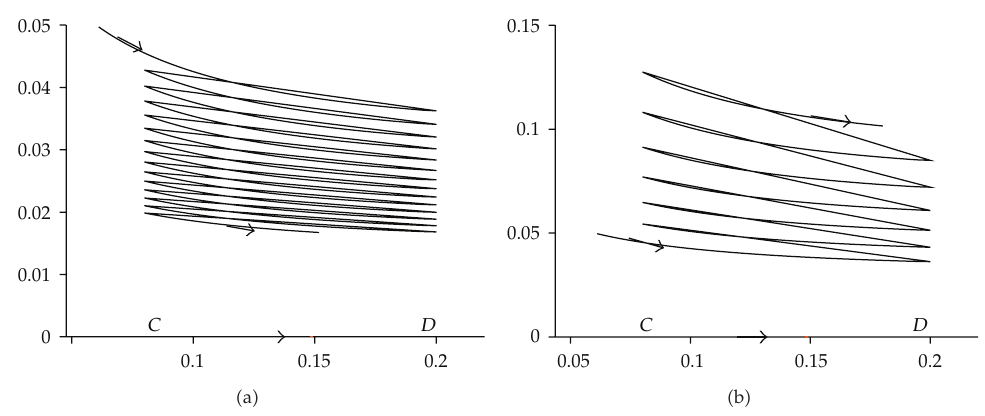
Figure 3: Trajectories with initial point (cid:9) 0 . 06 , 0 . 05 (cid:10) of system (cid:9) 1.3 (cid:10) with p (cid:6) 0 . 6, h (cid:6) 0 . 2 (cid:9) a (cid:10) q (cid:6) 0 . 18, (cid:9) b (cid:10) q (cid:6) 0 . 5.